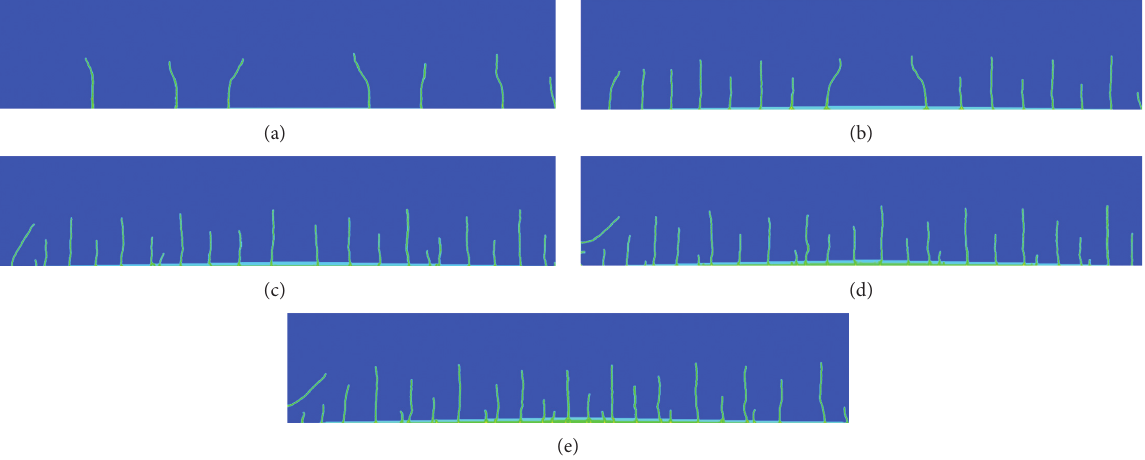
� 300 ° C; (b) T � 350 ° C; (c) T � 400 ° C; (d) T � 500 ° C; 0 0 0 0